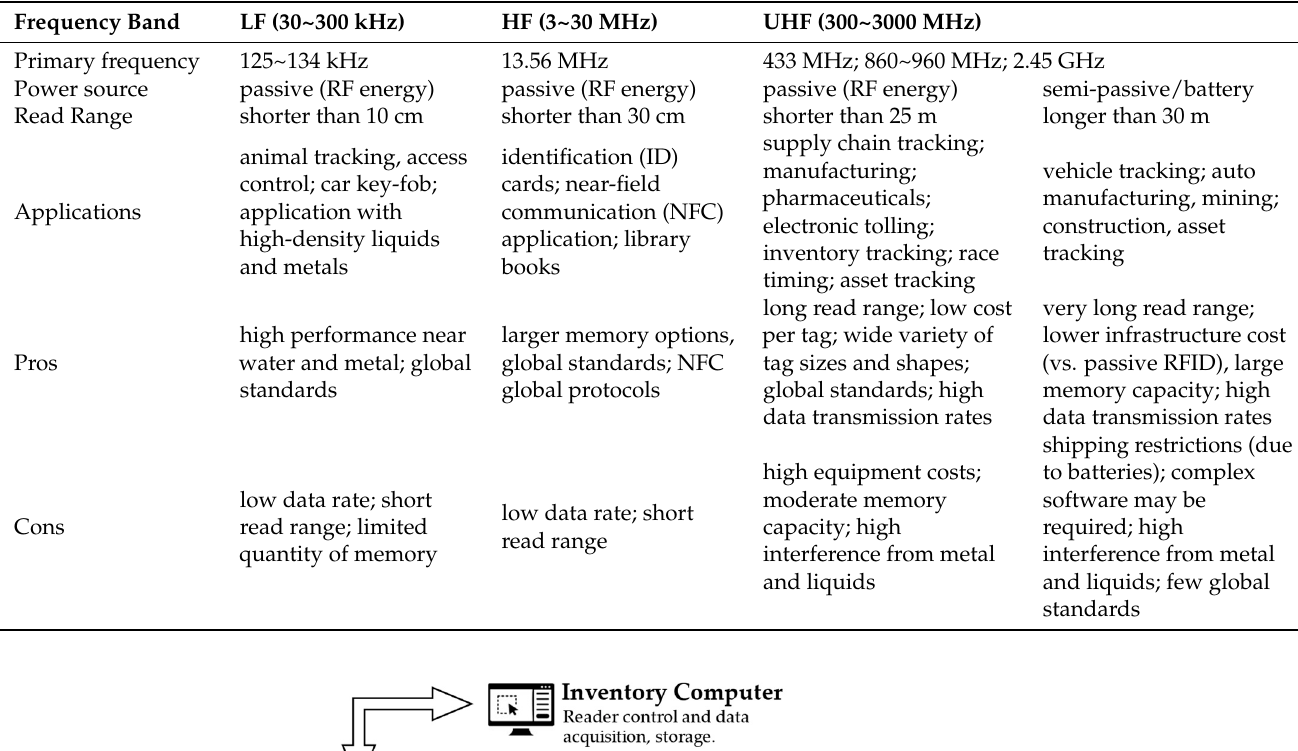
Table 2. Types of RFID operating in different frequency ranges [30].